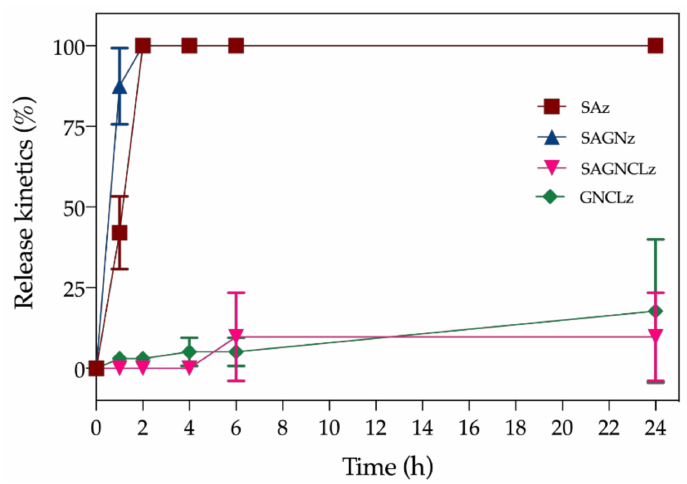
Figure 6. Release kinetics of Nisin Z from SAz, SAGNz, SAGNCLz and GNCLz incubated in SBF (pH 7.4) for a period up to 24 h in dynamic conditions (120